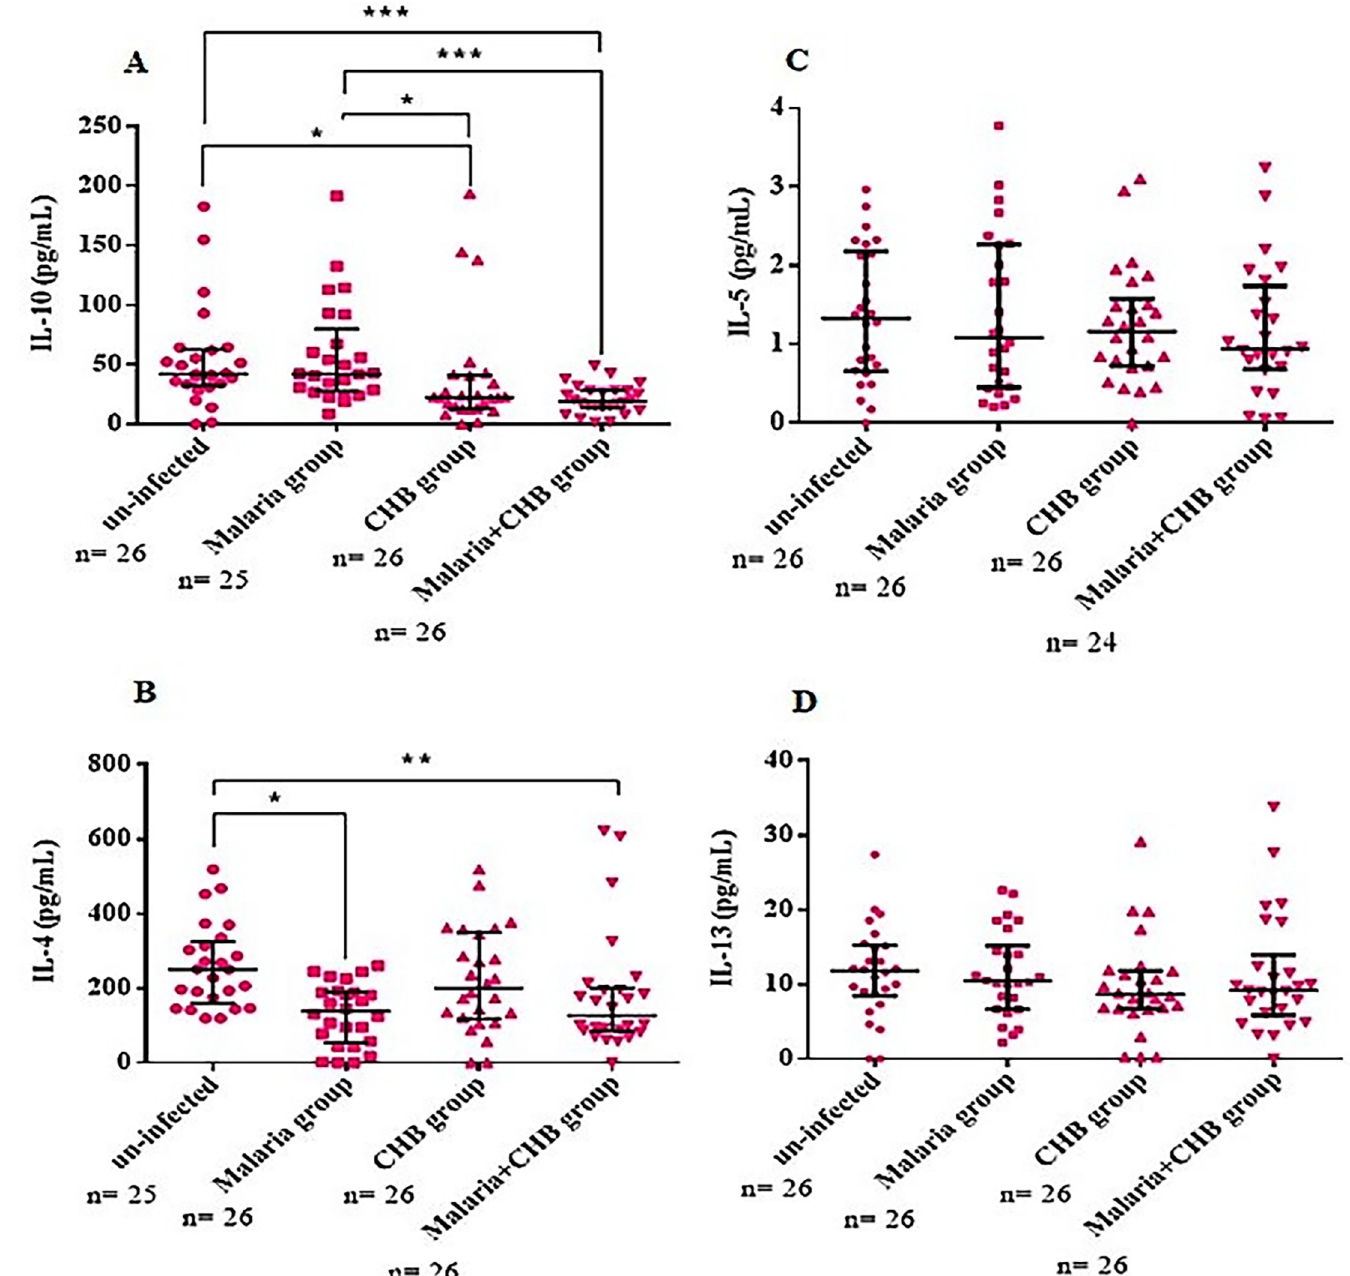
Fig 4. Comparison of serum levels of anti-inflammatory cytokines in the different categories of pregnant women. Dunn’s multiple comparison tests for significant P- values in levels of (A) IL-10, (B) IL-4 (C) IL-5 and (D) IL-13. Statistical significance was observed at � P < 0.05, �� P < 0.01 and ��� P < 0.001. Horizontal bar with error bars represents the median and the interquartile range respectively. n = number of samples of each category of the study participants assayed.